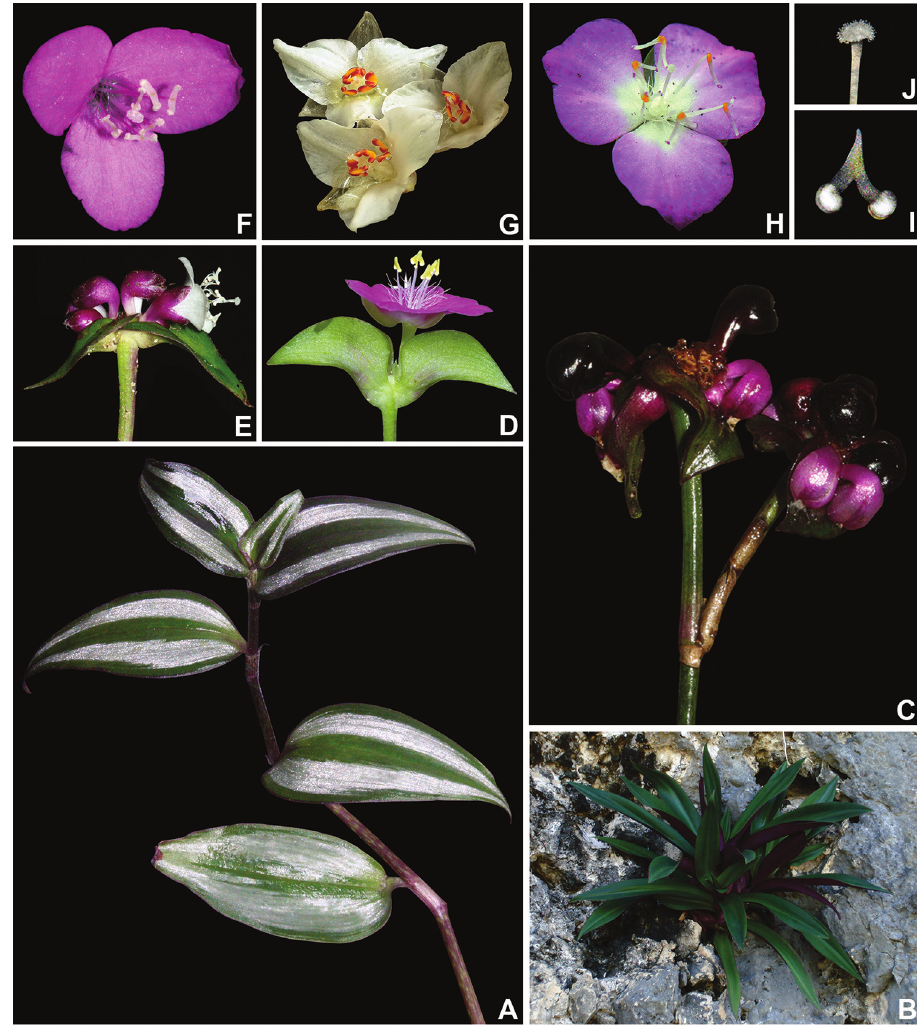
Figure 10. Tradescantia subg. Campelia (Rich.) M.Pell. A–B habit: A prostrate habit of T. zebrina Heyhn. ex Bosse, also showing the distichously-alternate, subpetiolate, striped leaves B rosette habit of T. spathacea Sw., also showing the spirally-alternate and sessile leaves C–E inflorescence: C synflorescence showing the presence of a coflorescence, also showing the berry-like fruits of T. zanonia (L.) Sw. D main florescence of T. polliae D.R.Hunt, showing the basally fused, folded, non-saccate, not overlapping, cin- cinni bracts and flat flower E main florescence of T. zanonia , showing the basally free, not folded, saccate, overlapping cincinni bracts, geniculate pedicels at anthesis and pre-anthesis, and the infundibuliform flower F–H flowers: F oblique view of a flower of T. zebrina G cluster of flowers of T. spathacea , showing the orange to red anther sacs H oblique view of a flower of T. commelinoides Schult. & Schult.f., showing the linearly-tapered connectives I anther of T. zanonia , showing the sagittate connective and round anther sac. J style of T. zanonia , showing the capitate stigma. A, C, E, F, I, J by M.O.O. Pellegrini, B by L. Gut- ierrez, D by F.A. Michelangeli, G by S. Neuwirth, and H by P.